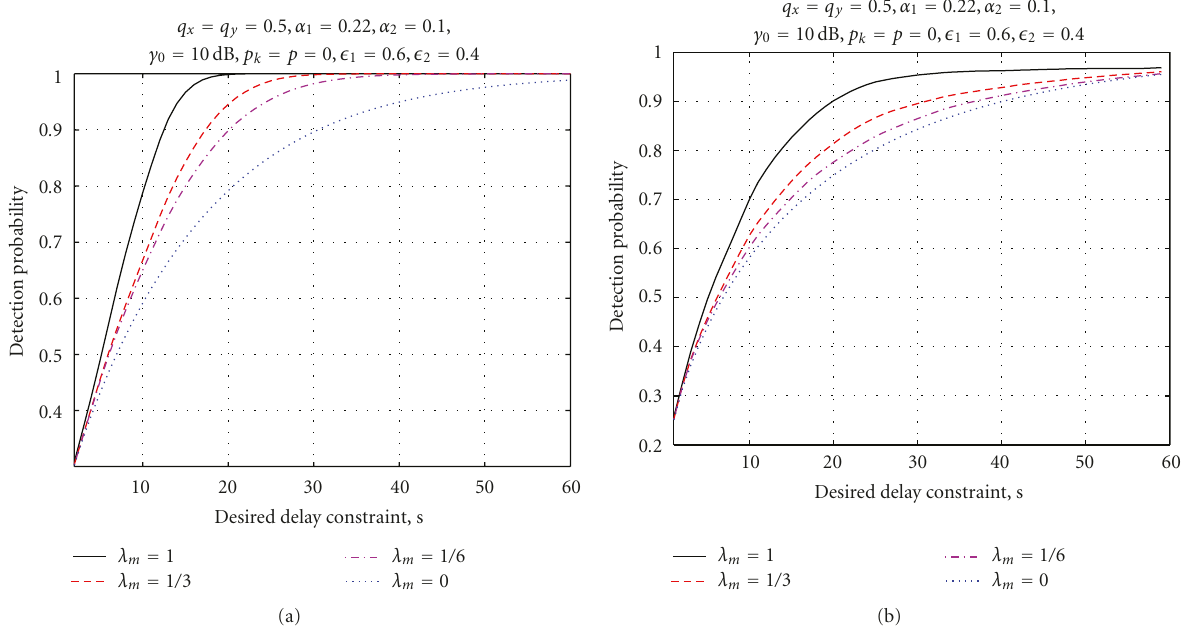
Figure 6: Detection Probability at the fusion center with desired detection delay under perfect communication: T s = 1s, v = 1m/s, γ 0 = 10 dB, p = 0, q x = q y = 0 . 5, α 1 = 0 . 22, α 2 = 0 . 1, (cid:2) 1 = 0 . 6, (cid:2) 2 = 0 . 4 (a) with decision fusion model 1, (b) with decision fusion model